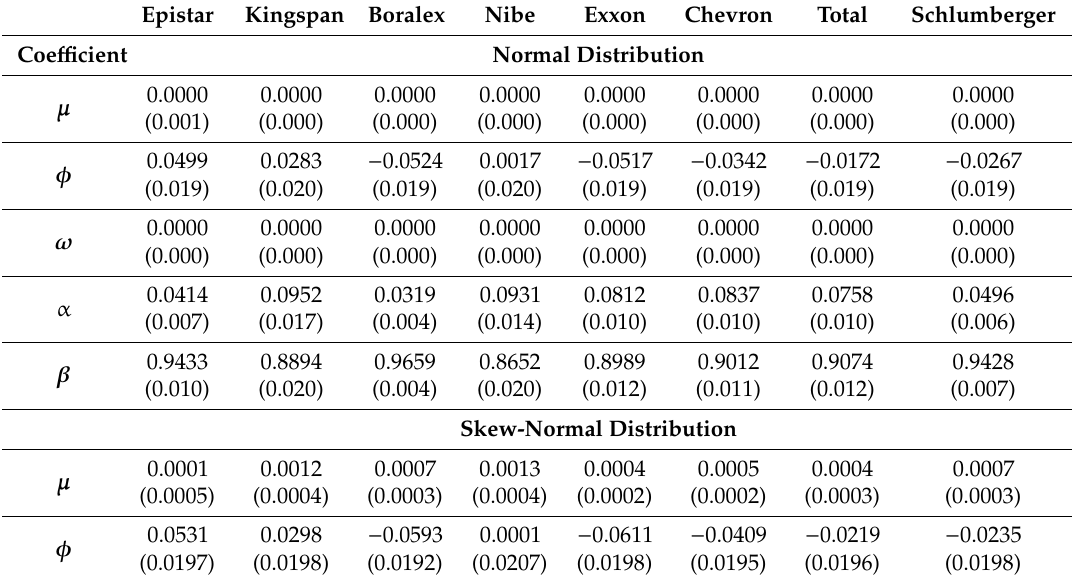
Table A2. Estimation of AR(1)-GARCH(1,1)